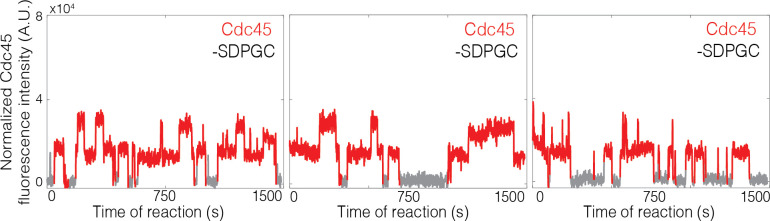
Representative records of Cdc45SORT649 fluorescence intensity.Additional example fluorescence-intensity records of Cdc45SORT649 from the experiment shown in Figure 2A. Cdc45 recruitment reactions including Sld3/7 but without Sld2, Dpb11, Pol e, GINS, and S-CDK (SDPGC). Points colored as in Figure 2B.